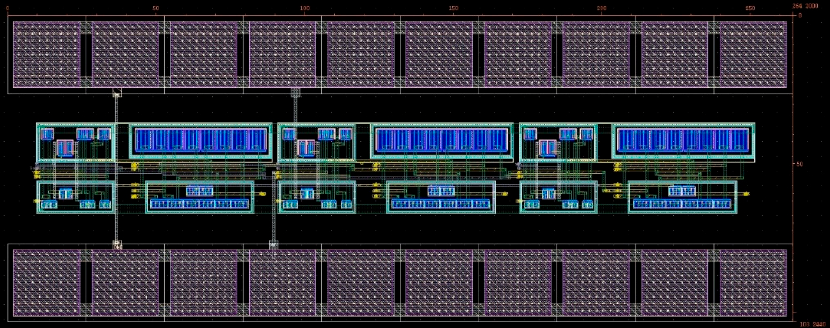
Figure 14. The core of the proposed mixed-mode biquadratic filter.